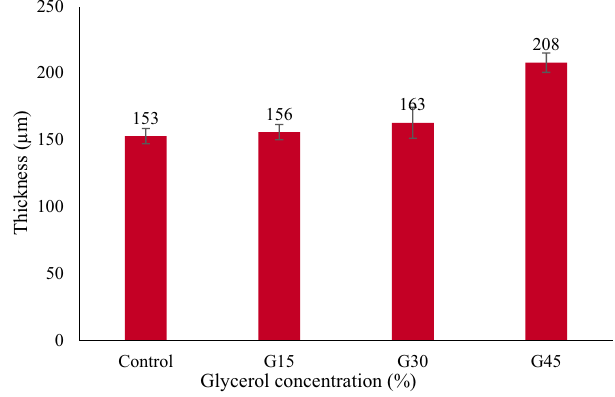
Figure 4. AS film thickness with different concentrations of glycerol.